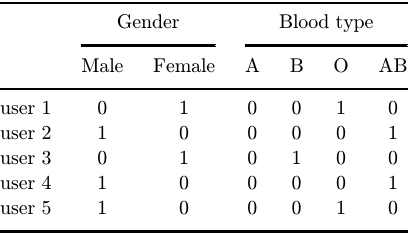
Table 2. Example of a bit map of pro¯les.